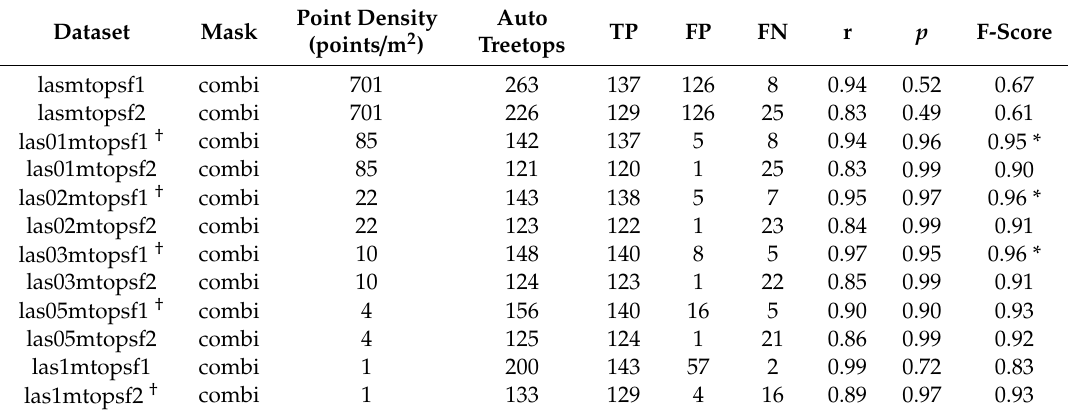
Table 8. The accuracy of treetop detections using a local maxima filter algorithm applied to tested PPCs with the di ff erent point density. The number of reference treetops is 145. Dataset